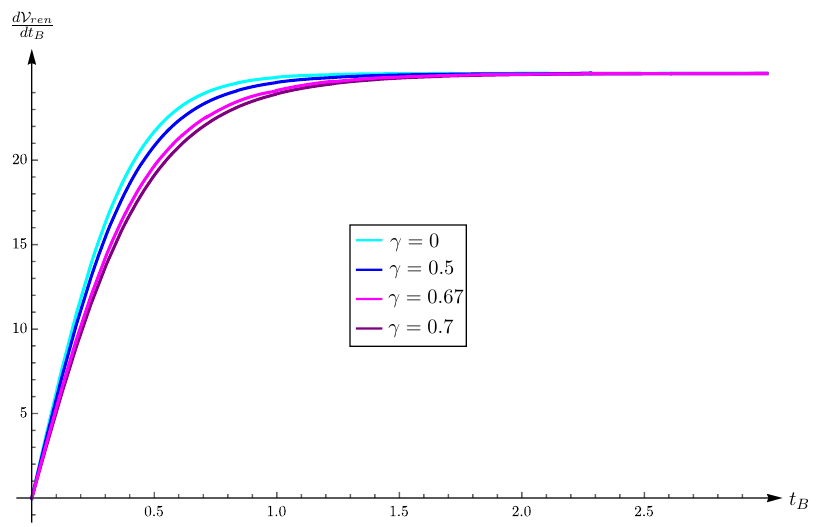
Figure 12 . Time derivative of the extemal volume of the time dependent Janus BTZ deformation for various values of γ